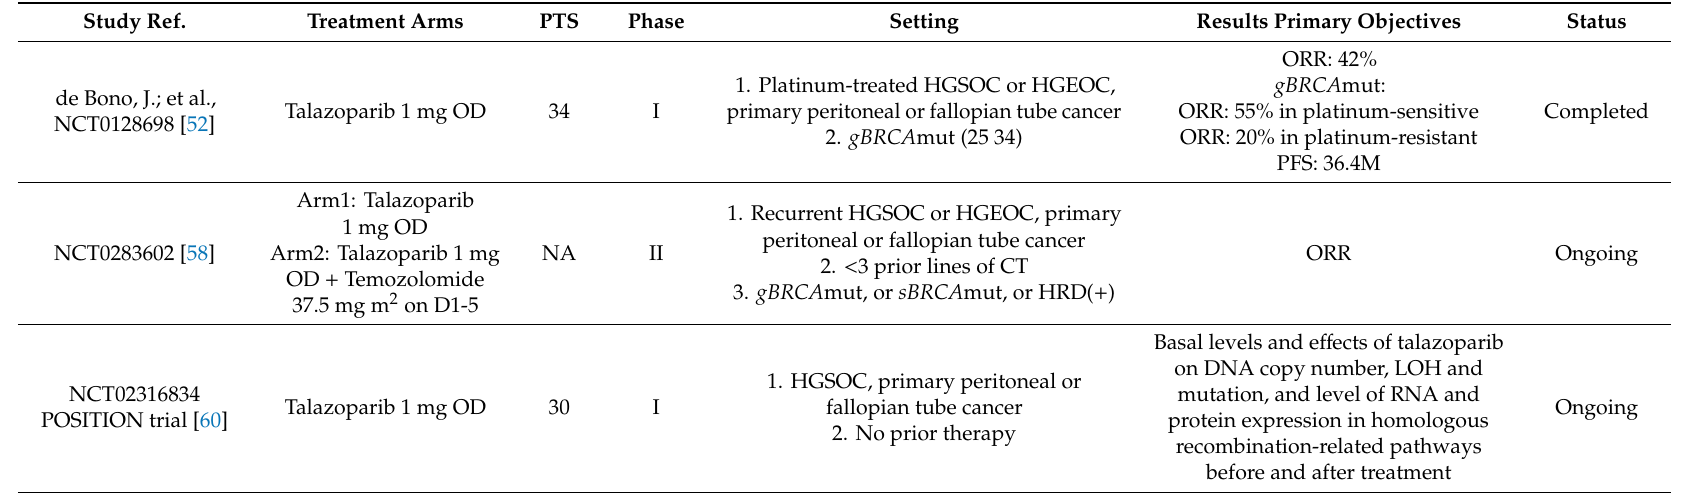
Table 5. Clinical trials results for Talazoparib in ovarian